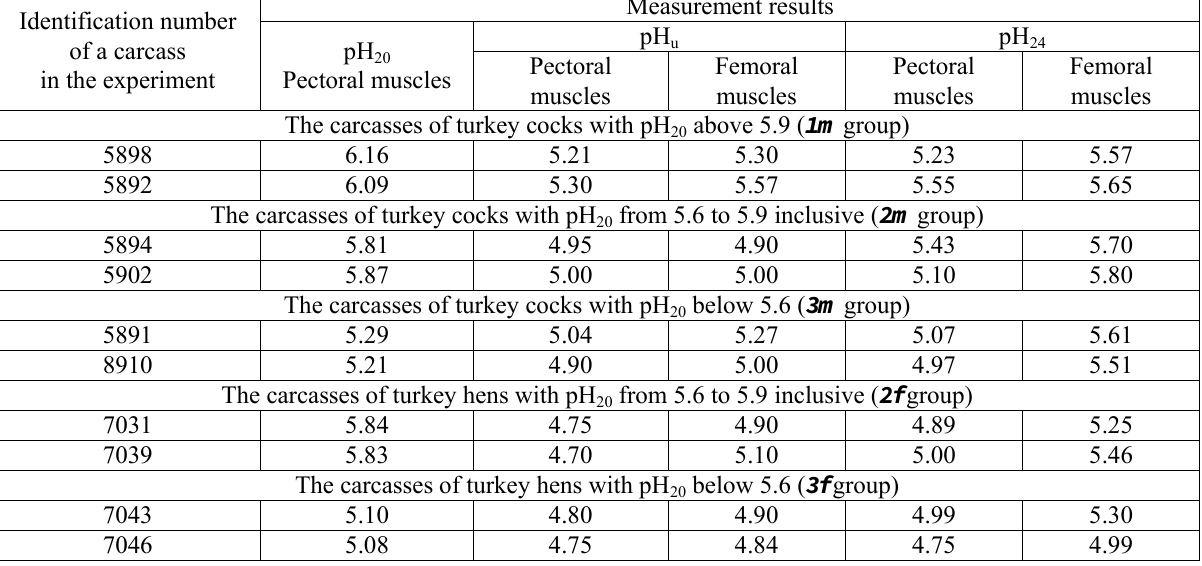
Table 1. Results of pH-metry of the carcasses of turkey cocks and turkey hens selected for histological studies Identification number of a